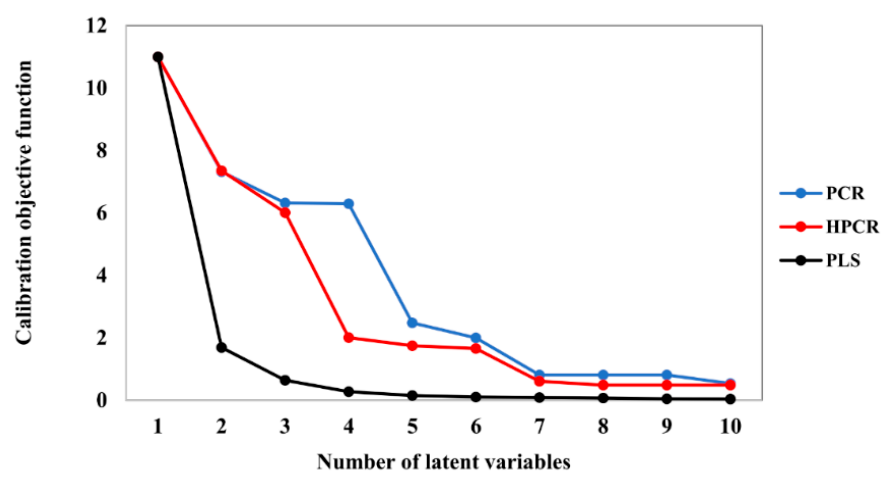
Figure 6. Principal directions of model calibrations using PLS, PCR and H-PCR at 90 °C and 450 rpm ( a ) first principal direction;